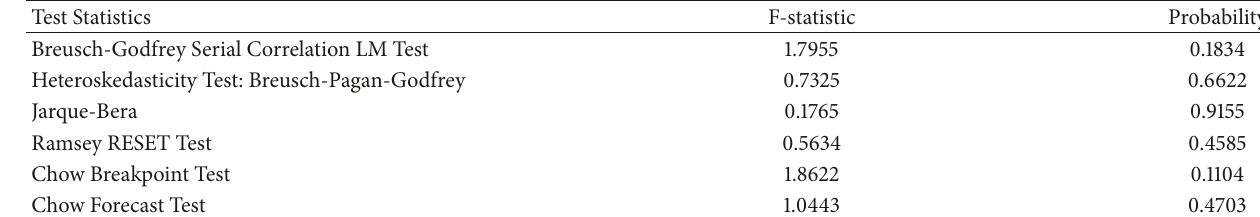
Table 6: Model diagnostic tests.